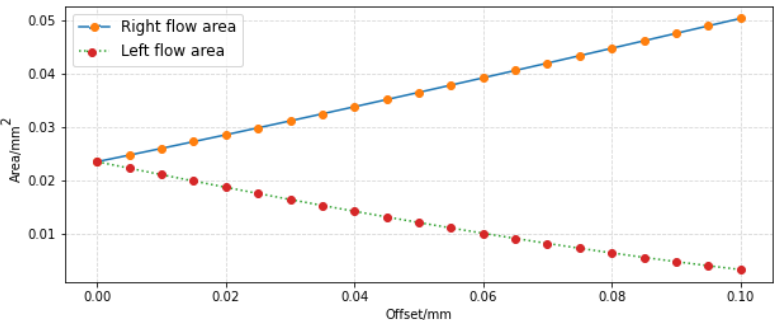
Figure 13. Variation curves of through-flow area.